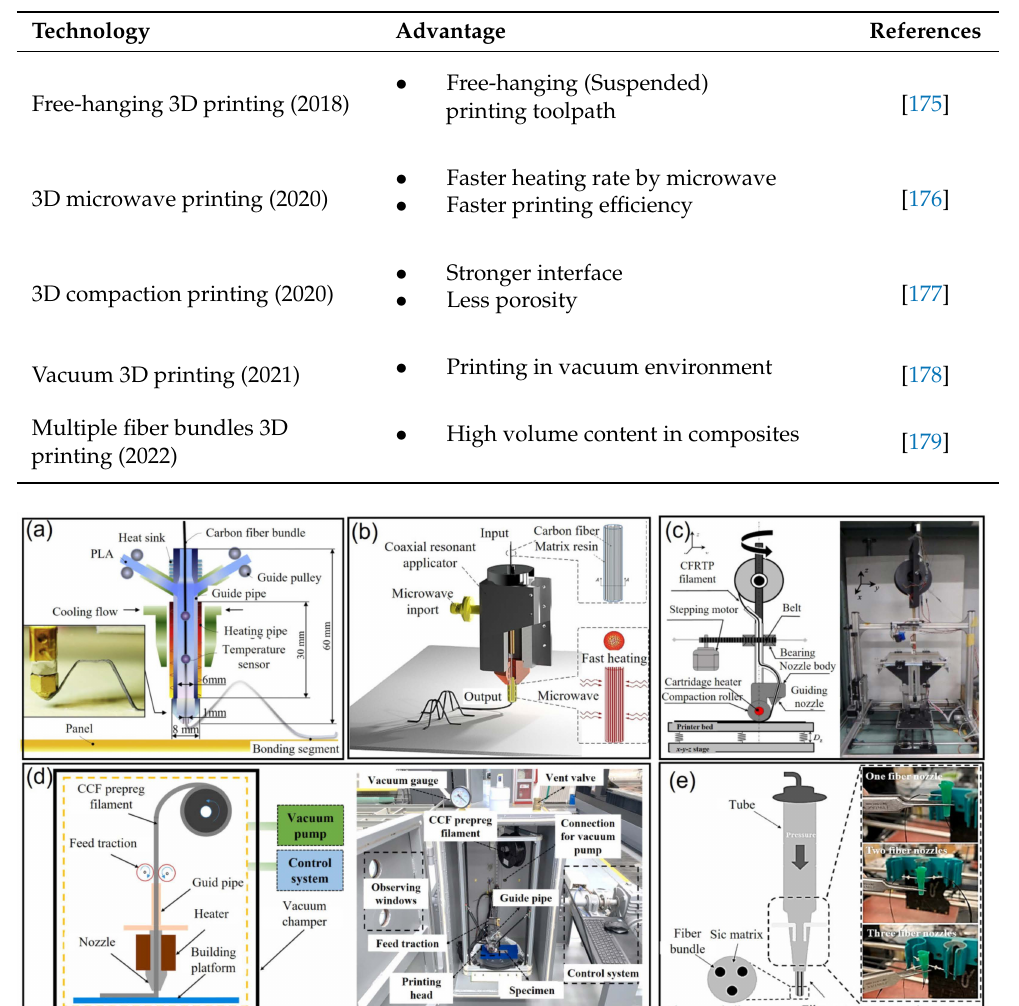
Table 1. Development of traditional additive manufacturing technologies for continuous carbon fiber-reinforced composites.